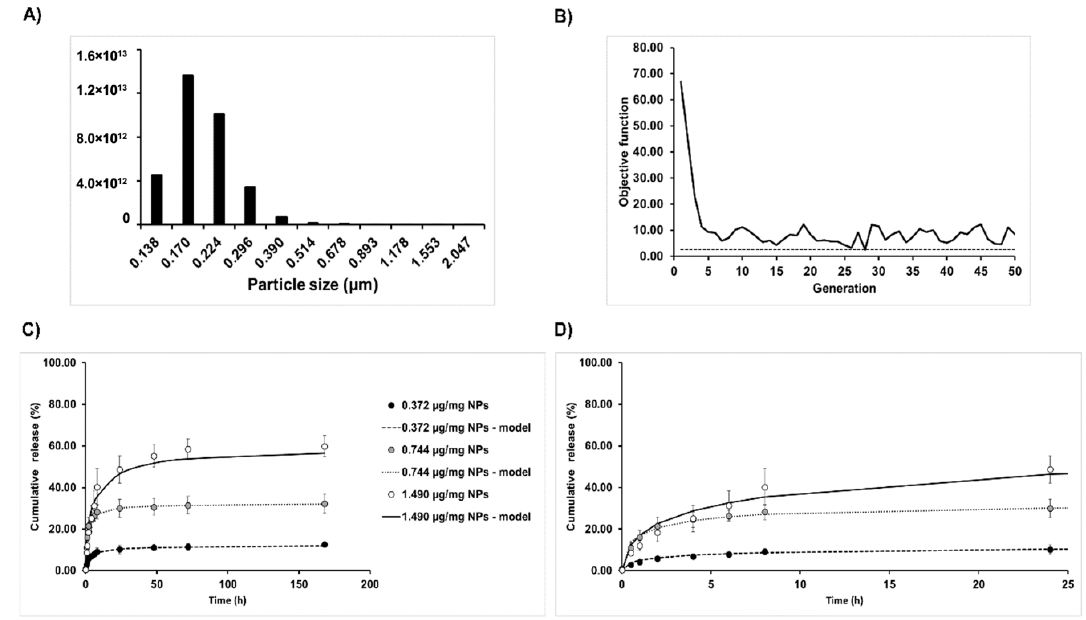
Figure 4. Mathematical modeling of CXCL12 release. ( A ) Particle size classes used in the modeling process adapted from laser diffraction results. ( B ) Representative graphic showing the objective function to minimize with respect to the number of generation performed with the evolutionary optimization algorithm. ( C ) Mathematical modeling of CXCL12 for different initial loading mass. Dashed lines show modeling results. ( D ) Mathematical modeling results for the first 24 h (zoom from C ).